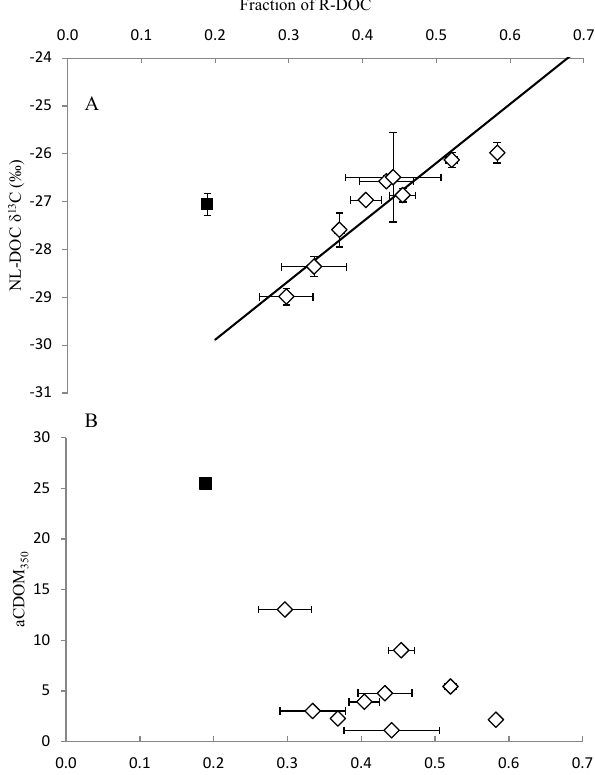
Figure 5. (A) Fraction of NL-DOC resistant to photooxidation fol- lowed by bacterial incubation (R-DOC) as a function of the δ 13 C signature of NL-DOC, and (B) the absorption coefficient at 350nm for all riverine samples. The error bars in (A) represent the propa- gated uncertainty for the fraction of NL-DOC remaining following the two treatments. The trend line describes a model 2 linear regres- sion including all data except the Congo